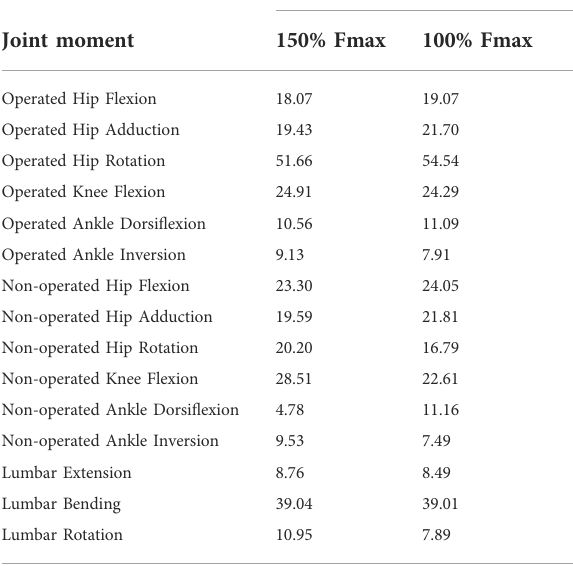
TABLE 6 Root-mean-square (RMS) differences between pre-surgery and predicted post-surgery joint moments. Percentage of Fmax indicates the percent of pre-surgery psoas peak isometric strength used to generate the post-surgery walking